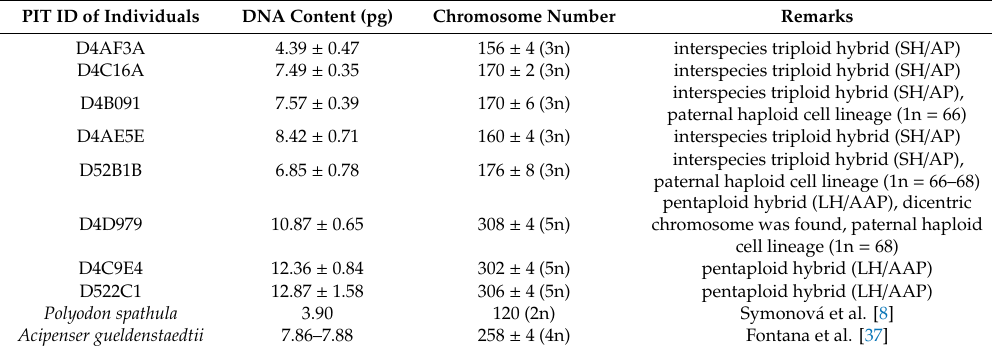
Table 5. DNA content and chromosome number of the di ff erent hybrid types (SH / AP and LH / AAP). AP was an interspecies triploid hybrid with two maternal (4n) genomes and one paternal (2n) genome characterized by small genome size (SH). AAP was an interspecies pentaploid hybrid with four maternal genomes and one paternal genome characterized by large genome size (LH). PIT IDs are the individual numbers of internal tags for individual